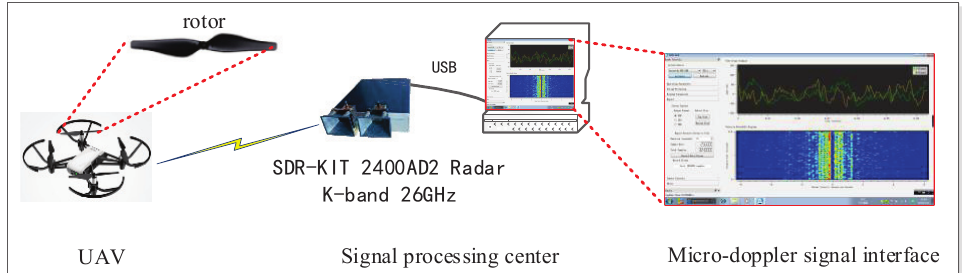
Micro-doppler signal interfaceSignal processing center